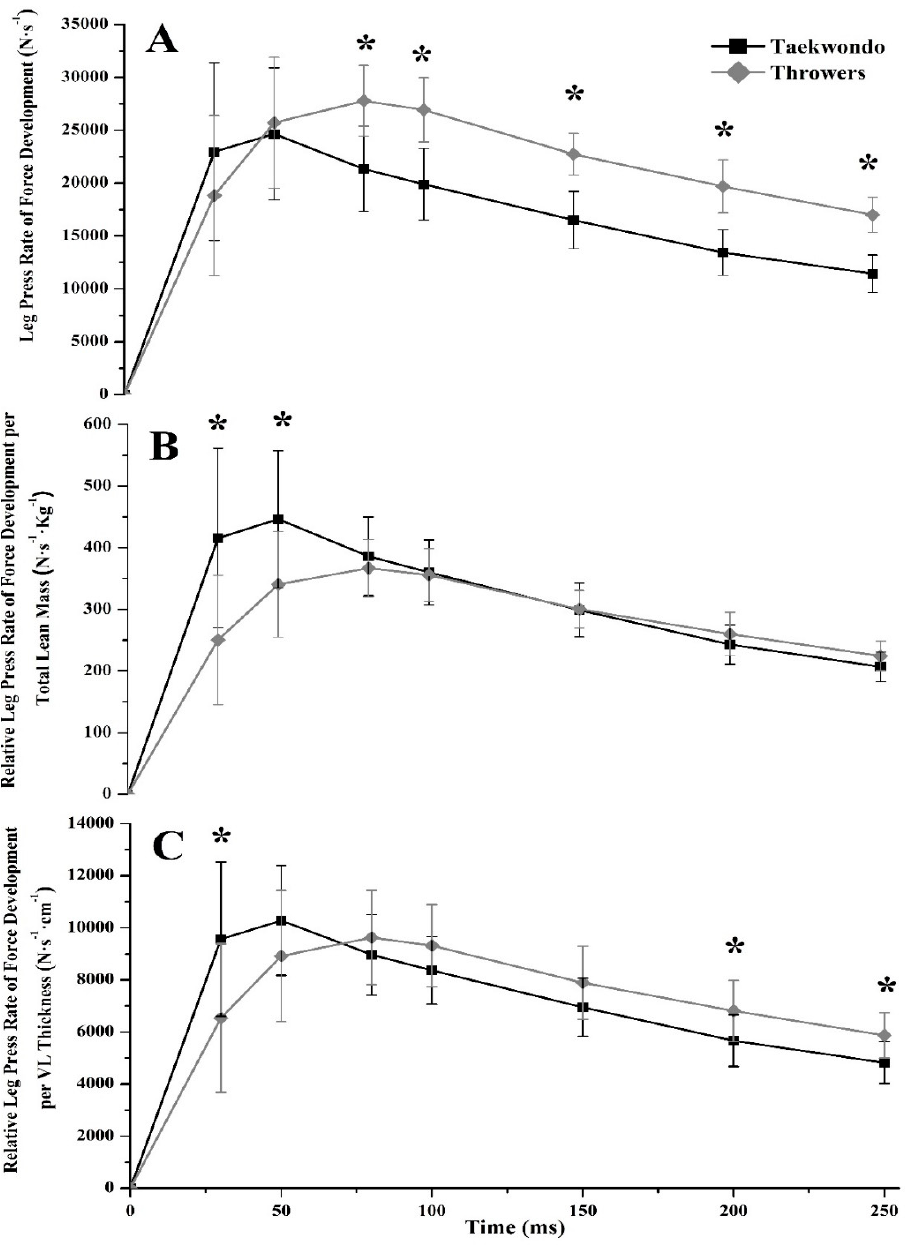
Figure 1. Leg press rate of force development (RFD) curves of taekwondo (black line) and thrower (grey line) athletes. ( A ) Leg press RFD curve in absolute values. Throwers had significantly higher RFD between 80–250 ms as compared to taekwondo athletes (* p < 0.05). ( B ) Leg press RFD curve relative to total lean mass. Taekwondo athletes had significantly higher RFD compared to throwers at 30 ms and 50 ms after contraction initiation (* p < 0.05). ( C ) Leg press RFD curve relative to vastus lateralis muscle thickness. Taekwondo athletes had significantly higher early RFD 30ms compared to throwers, while throwers had significantly higher late RFD 200–250ms (* p < 0.05) compared to taekwondo athletes.